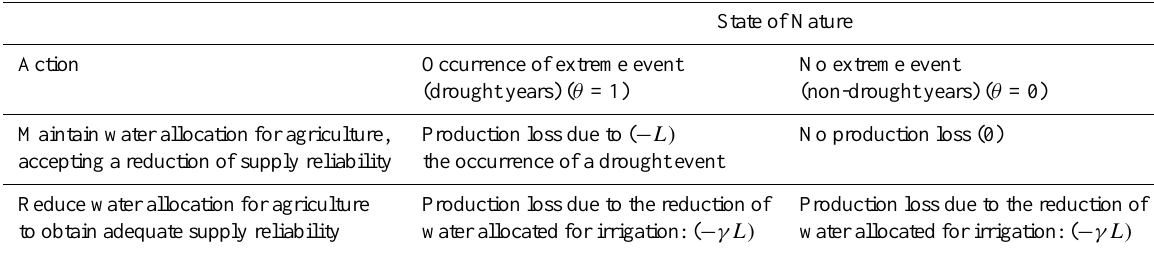
State of Nature